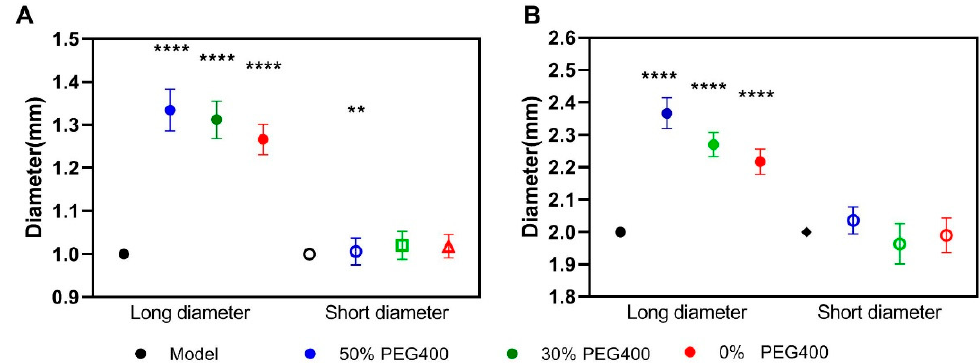
Figure 3. Diameter uniformity of pellets fabricated with different formulations ( n = 10). ( A ) The long and short diameters of 1 mm pellets with different formulations; ( B ) the long and short diameters of 2 mm pellets with different formulations. (** = p < 0.01, **** = p < 0.0001)